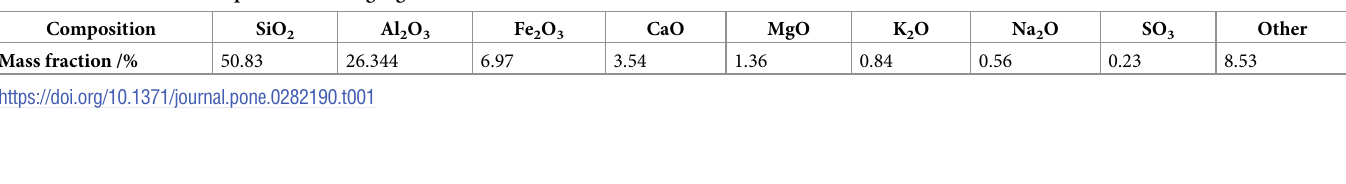
Table 1. Main chemical composition of coal